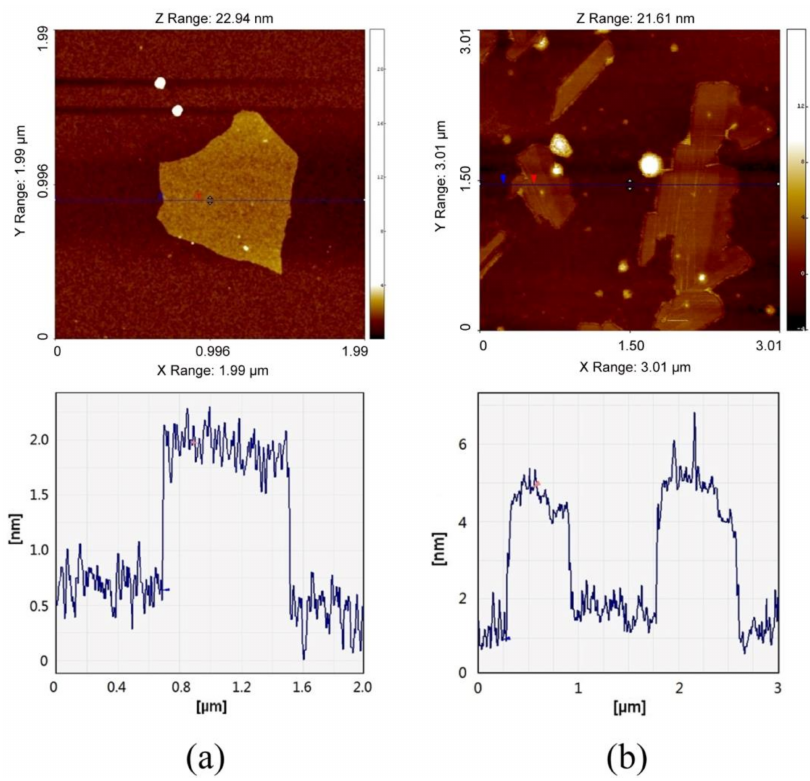
Figure 4. AFM images and corresponding height profiles of GO ( a ), GO-PMDA ( b